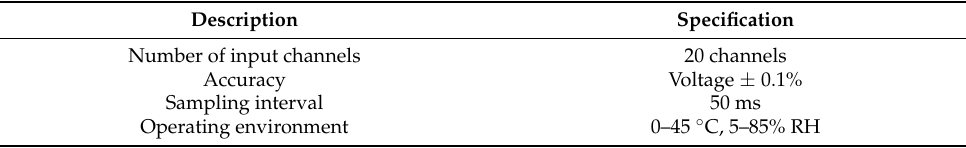
Table 3. Specifications of the data logger used for data collection.